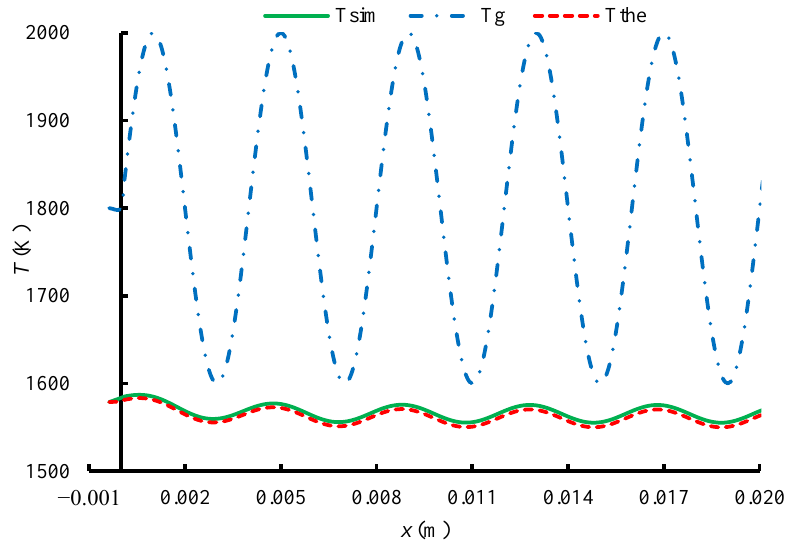
Figure 6. Theoretical and numerical wire temperature comparison ( L w = 0.04m, thermocouple 3).